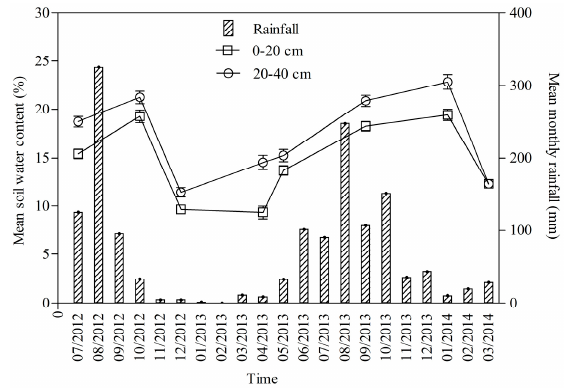
Figure 3. Variations in average soil moisture in the top ‐ and subsoil layers, and monthly rainfall in the Laozhai catchment from July 2012 to March 2014. The bars represent standard error of the mean of 51 samples.